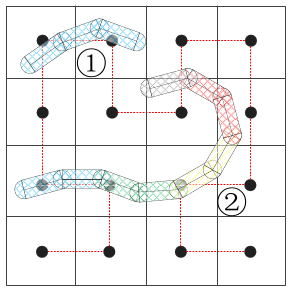
Figure 5. Boundary object processing